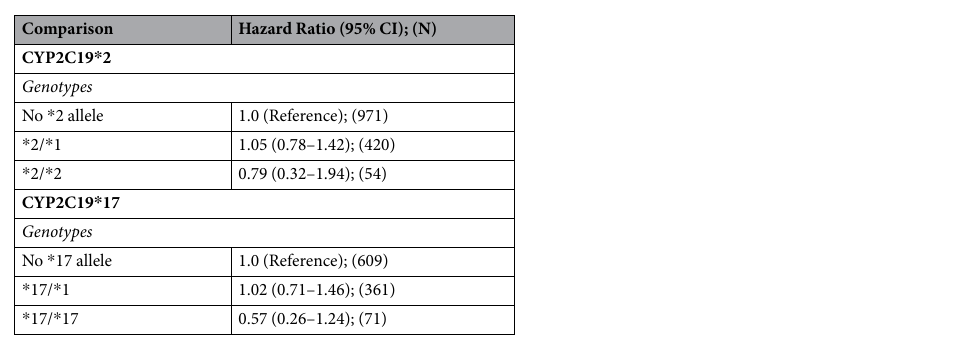
Table 3. Cox proportional hazard ratios for CYP2C19 * 2 and CYP2C19 * 17 genotypes and Disease Free